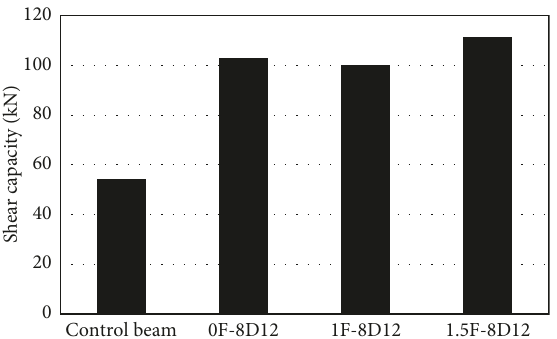
Figure 7: Shear enhancement of beams with different steel fiber volume fractions.